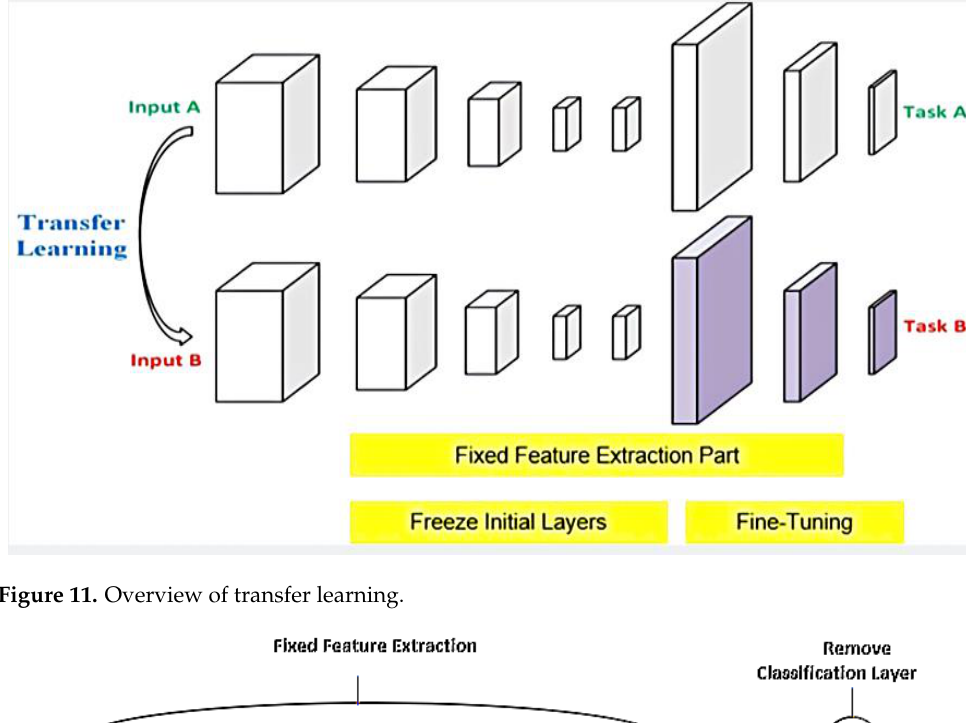
Figure 11. Overview of transfer learning.